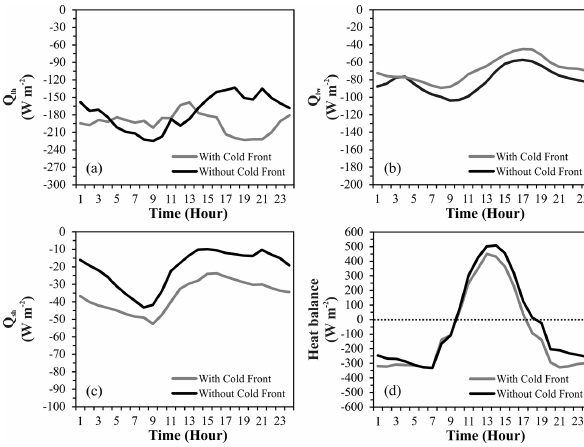
Figure 10. Impacts of a cold front on the heat flux: (a) latent heat, (b) net longwave, (c) sensible heat and (d) total heat